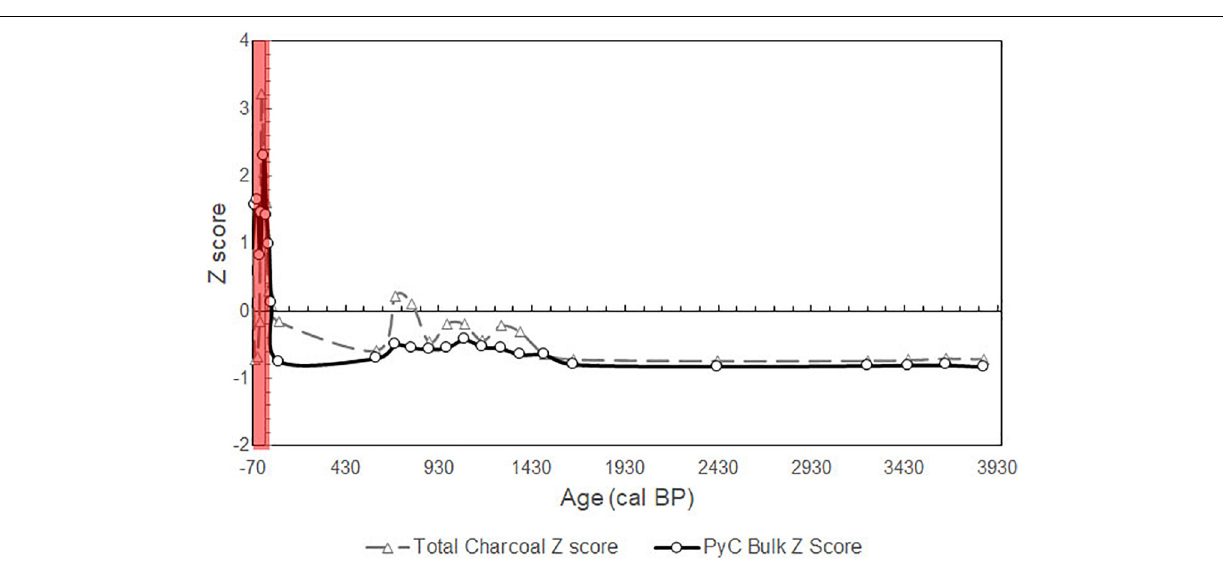
FIGURE 7 | Z scores of total charcoal particle influx (gray dashed line, triangle markers) and pyrogenic carbon influx (black line, circle markers) for Big Willum Swamp core BWIL2. High relative fire intensities (red bars) are identified by positive pyrogenic carbon Z scores and low to negative total charcoal Z